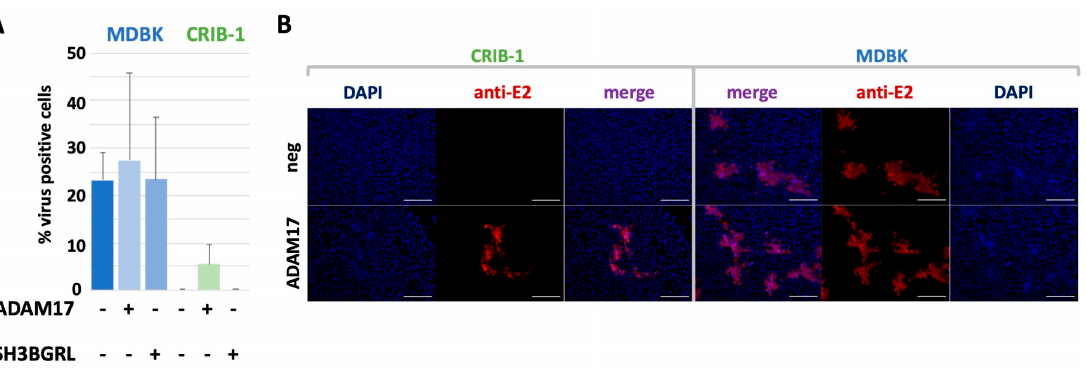
Figure 4. Effect of ADAM17 transcomplementation on BVDV spread. ( A ) Analysis of BVDV spread by flow cytometry. The amount of infected MDBK or CRIB-1 cells with (+) or without ( − ) transcom- plementation of ADAM17 or SH3BGRL was quantified by flow cytometry 72 h after infection with BVDV C87 (E2-mClover) with an MOI of 0.001. Shown are mean and standard deviation of three independent experiments. ( B ) BVDV plaque morphology on MDBK or CRIB-1 cells with (ADAM17) or without (neg) transcomplementation of bovine ADAM17 after staining with the anti-E2 antibody 6A5. Cell nuclei were stained with DAPI. Scale bar = 200 µ